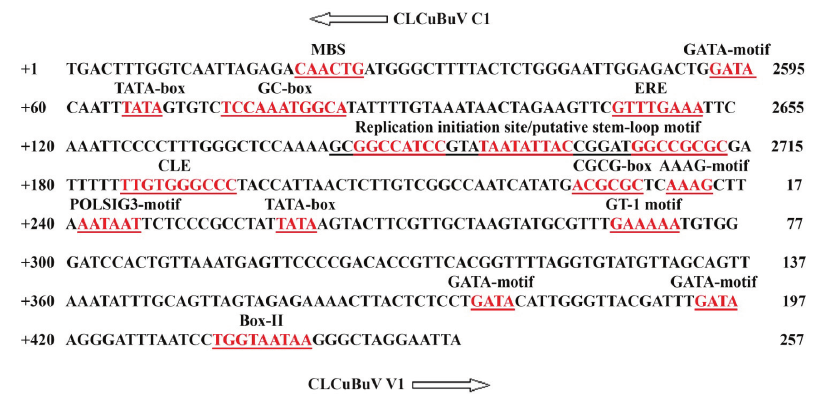
Figure 1. The 455 bp DNA sequence of the full-length transcript of the bidirectional gene promoter of the CLCuBuV coordinates from 2595–292 nucleotides in the viral genome. The putative motifs are in bold and underlined. The replication initiation site/putative stem-loop motif was composed of 35 bp consisting of ATC-motif (GGCCATCC) and GC-rich region (GGCCGCGC) around the nonanucleotide. The conserved late element (CLE) was present at position +185 was suggested to functional target for C2. The POLASIG3 motif (AATAAT) was also identified at position +242. The TATA-box for Rep promoter was found at position 65 nucleotide and TATA-box for Cp promoter was located at position 259 nucleotide in the LIR. The Box-II are predicted at position 433 in the LIR. MBS (MYB drought responsive element) was found at position 20 within the LIR. The labeling of motifs are indicated above the line. The right-side numbering shows the position of LIR in the